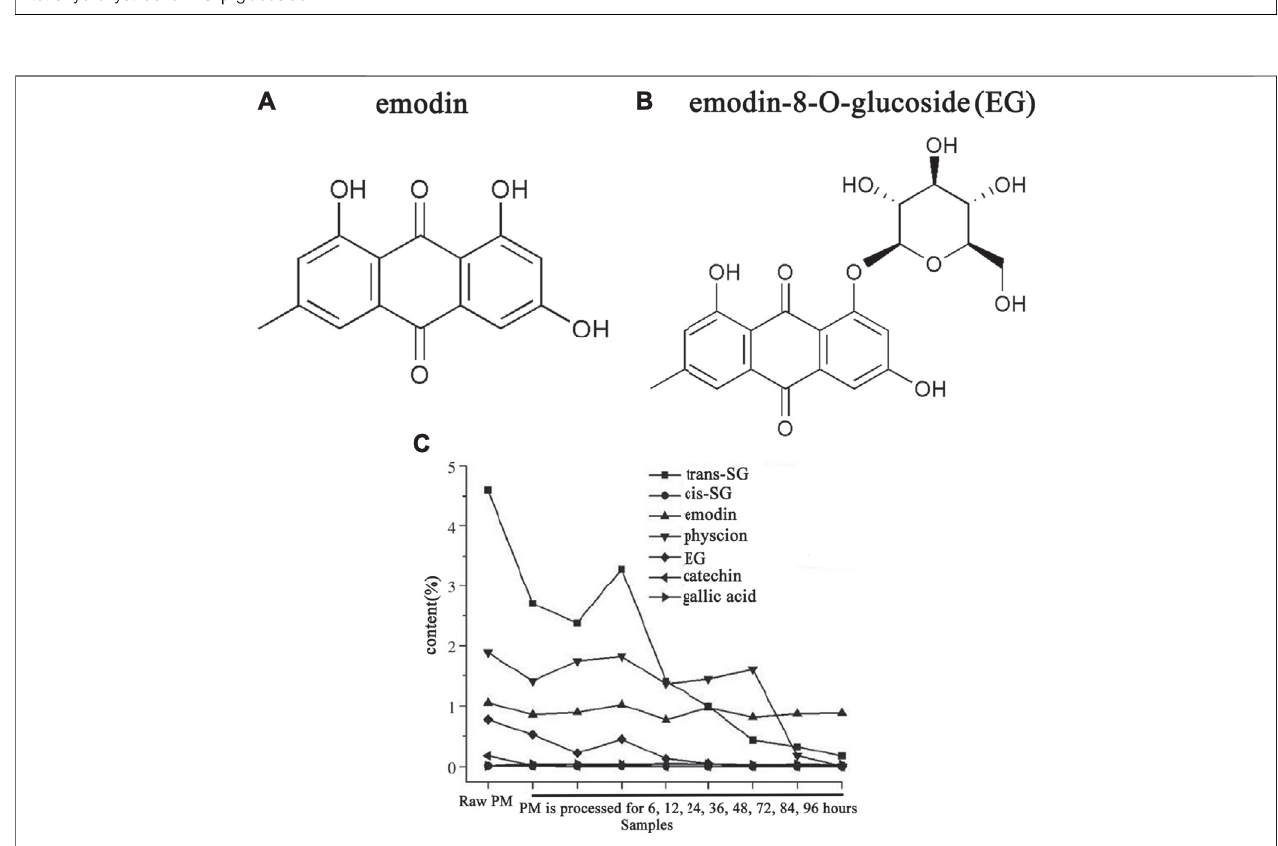
FIGURE 4 | The content of emodin-8-O-glucose (EG) of PM was reduced after processing. Adapted with permission from reference (Gao et al., 2017). Abbreviations: trans -SG, trans -2,3,5,4 ’ -tetrahydroxystilbene-2-O- β -glucoside; cis -SG, cis -2,3,5,4 ’ -tetrahydroxystilbene-2-O- β -glucoside;EG,emodin-8-O-glucoside; PM, Reynoutria multi fl ora (Thunb.)